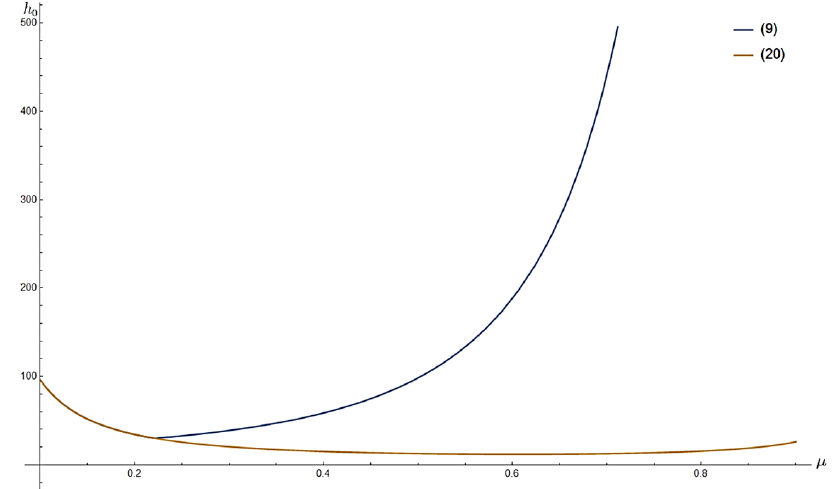
Figure 1. The minimum values of h 0 for which conditions (9) and (26) are